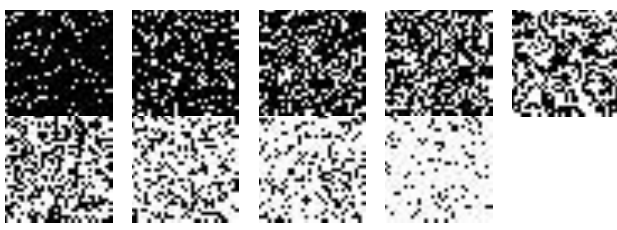
Figure 7. Examples of random noise images at a resolution of 32 × 32 that produced label densities from 0.1 to 0.9.